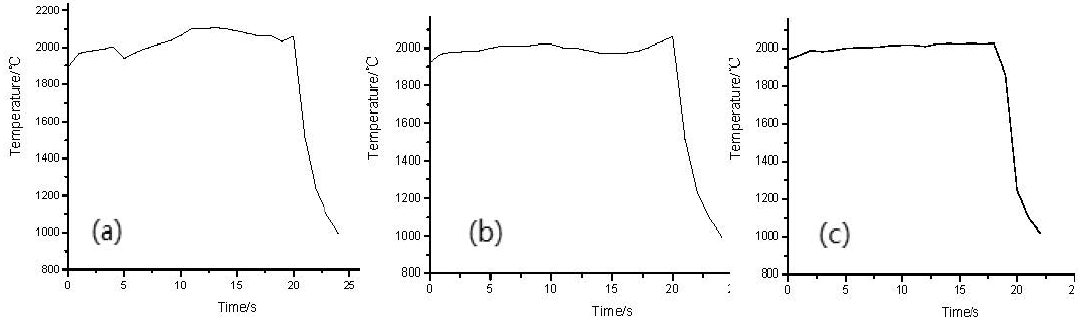
Figure 3. Evolution of the ablation temperature at the surface during the ablation tests for composites obtained with the following matrices: GPSD-PR ( a ); MPS-PR ( b ); and GPS-MPS-PR ( c